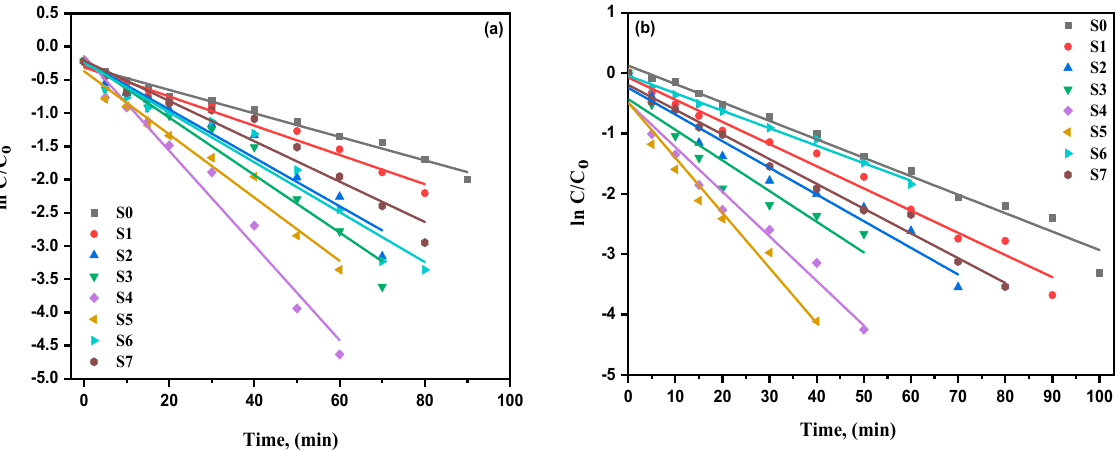
Figure 9. ( a , b ) Kinetic data for photodegradation using Eu 2 O 3 -ZnO of: ( a ) MB; ( b ) phenol.